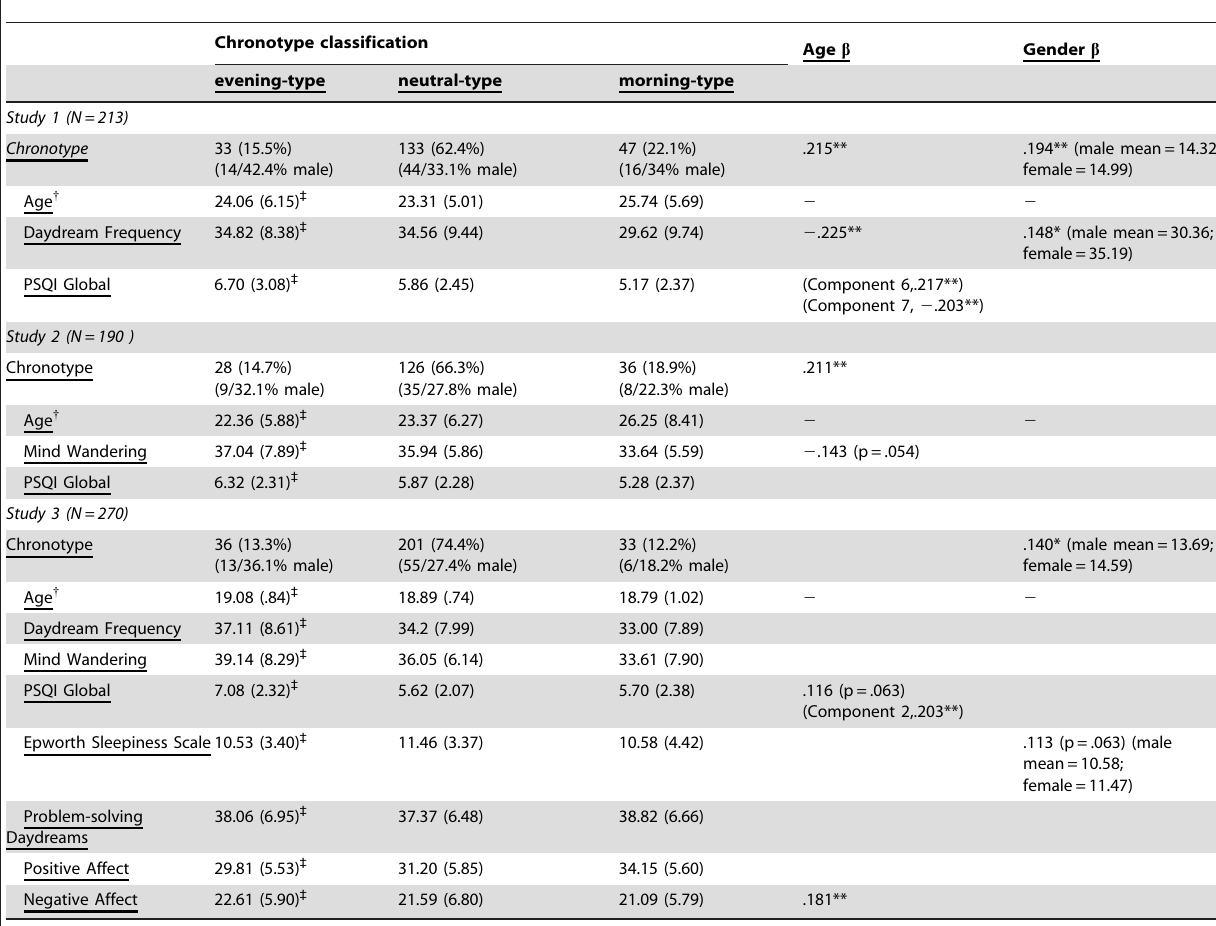
Table 2. Chronotype classifications, and descriptive statistics by